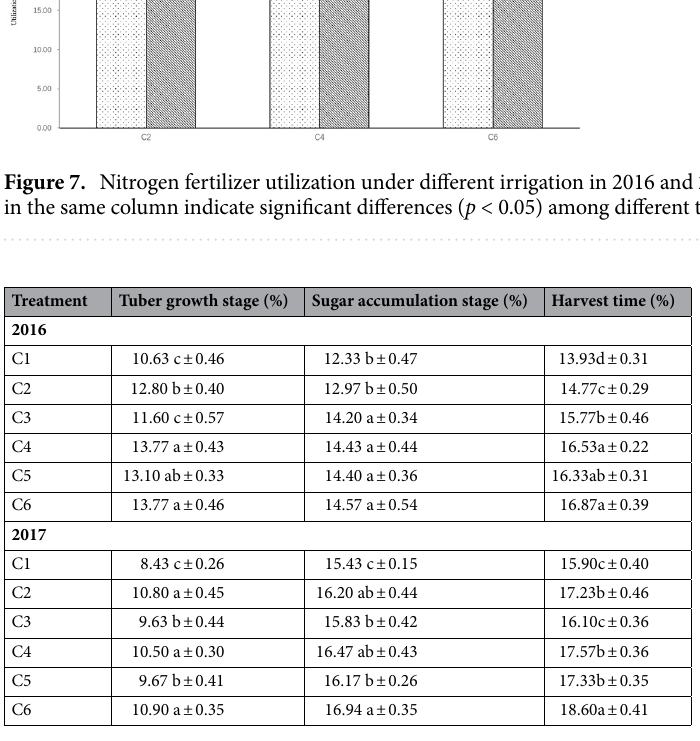
Table 1. Effect of limited irrigation on sugar content of sugar beet at various growth stages. Different lowercase letters in the same column indicate significant differences ( p < 0.05) among different treatments in the same year.